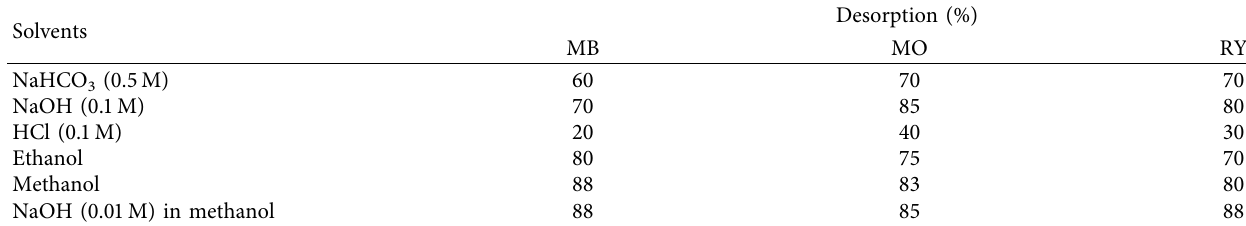
Table 6: Optimization of desorption solvent.